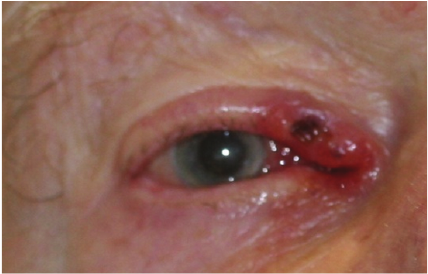
Figure 1: Nodular ulcerative lesion noted to right lid margin.